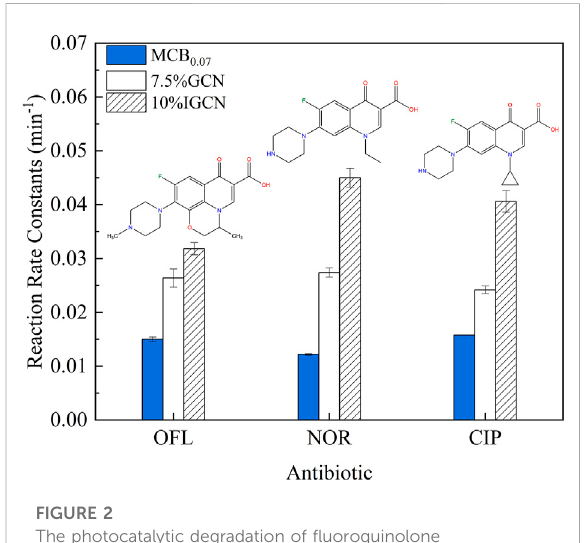
FIGURE 2 The photocatalytic degradation of fl uoroquinolone antibiotics on g-C 3 N 4